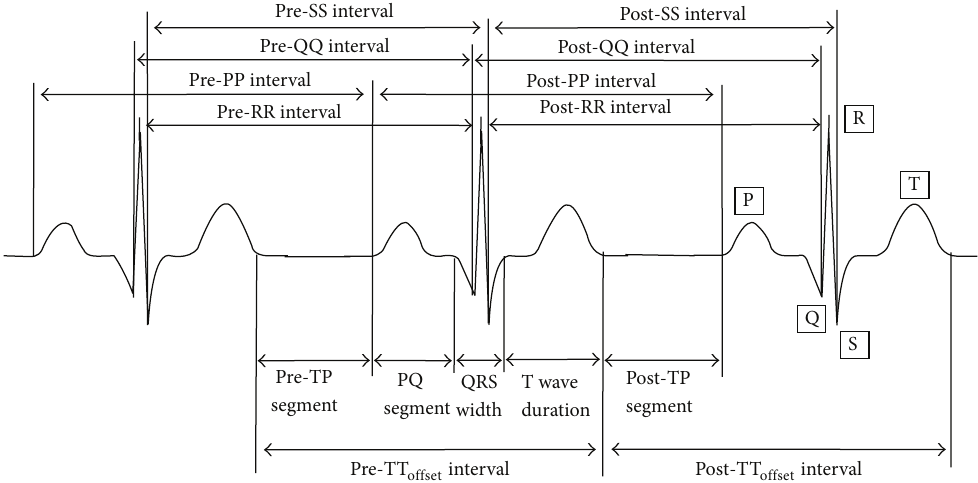
Figure 2: Extraction of heartbeat interval features and interbeat interval features from successive heartbeats.